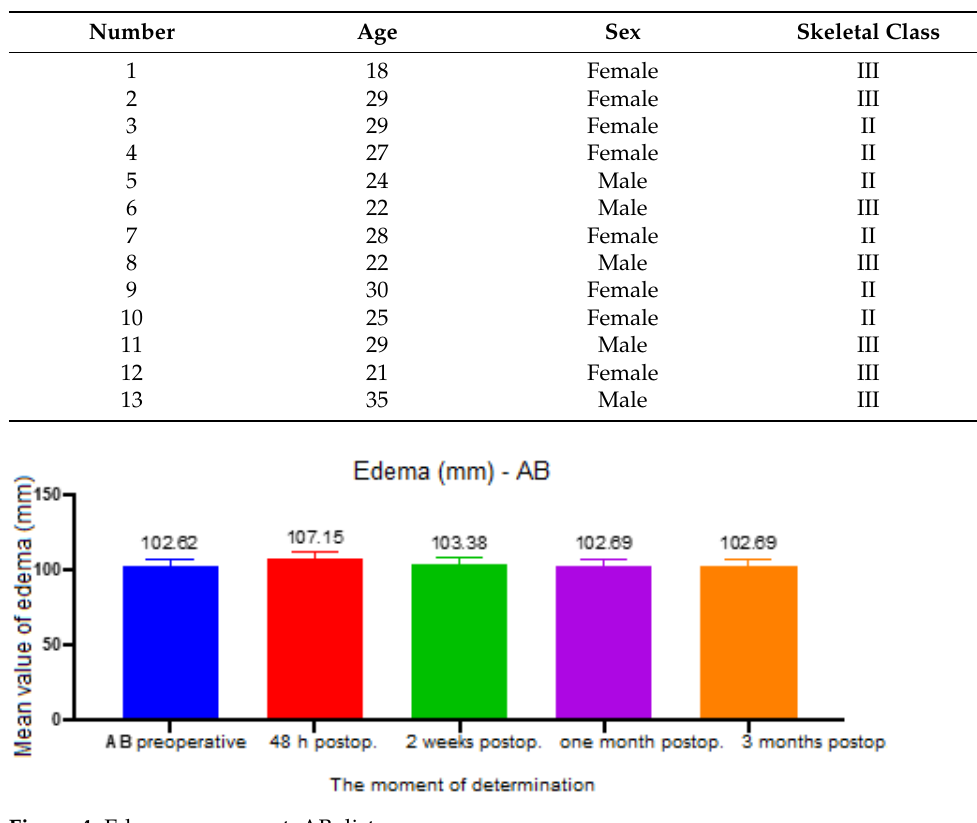
Figure 6. Edema assessment, CE distance. A two-way ANOVA test was used to analyze the mouth opening amplitude data that included, in addition to the moment of determination, the skeletal class (II or III). Taking the time variable into account, skeletal class had no effect on the amplitude of the mouth opening ( p = 0.44). The time of determination had a significant impact on the results, with a statistically significant difference between the groups ( p < 0.001). The test between groups was performed for each skeletal class individually. For Class II, there were statistically significant differences between preoperative and 2 weeks postoperative ( p = 0.006, mean difference = 32.42), preoperative and 4 weeks postoperative ( p = 0.02, mean difference = 21.75), 2 weeks postoperative and 3 months postoperative ( p = 0.01, mean difference = 24.58) and between 4 weeks postoperative and 3 months postoperative ( p = 0.02, mean difference = 13.92). For Class III, there were also statistically significant differences between all groups. Between preoperative and: 2 weeks postoperative ( p < 0.001, mean difference = 44.57), 4 weeks postoperative ( p < 0.001, mean difference = 28.43) and 3 months postoperative ( p = 0.006, mean difference = 11.43). Between 2 weeks and 4 weeks postoperative ( p < 0.001, mean difference = 16.14) and 3 months postoperative ( p < 0.001, mean difference = 33.14) and between 4 weeks and 3 months postoperative ( p < 0.001, mean difference = 17) (Figure 7).